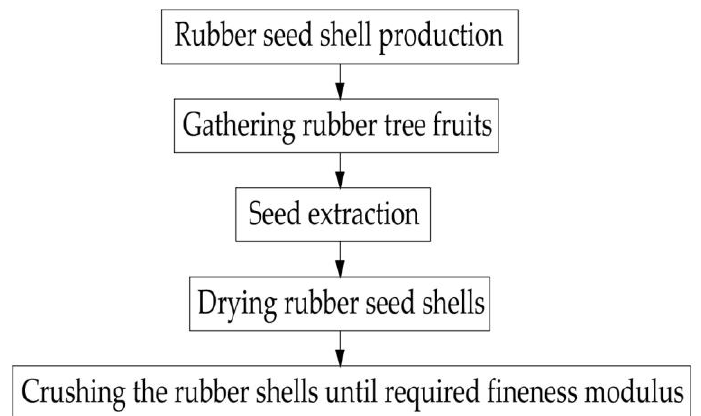
Figure 2. Method for obtaining CA based on the shell of the seeds of the RT.